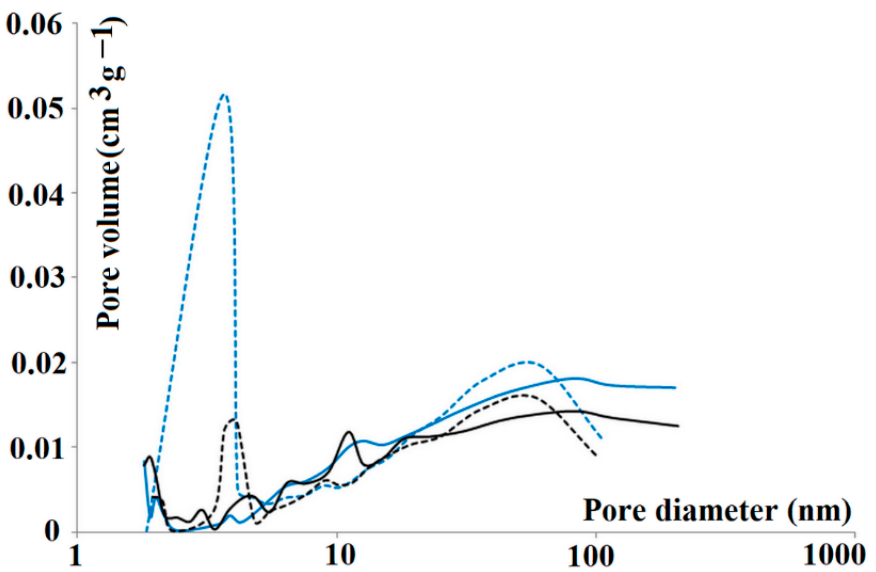
Figure 3. Pore size distributions on adsorption (solid lines) and desorption (dashed lines) branches of isotherms of all tested materials: m-MIP (blue) and m-NIP (black).